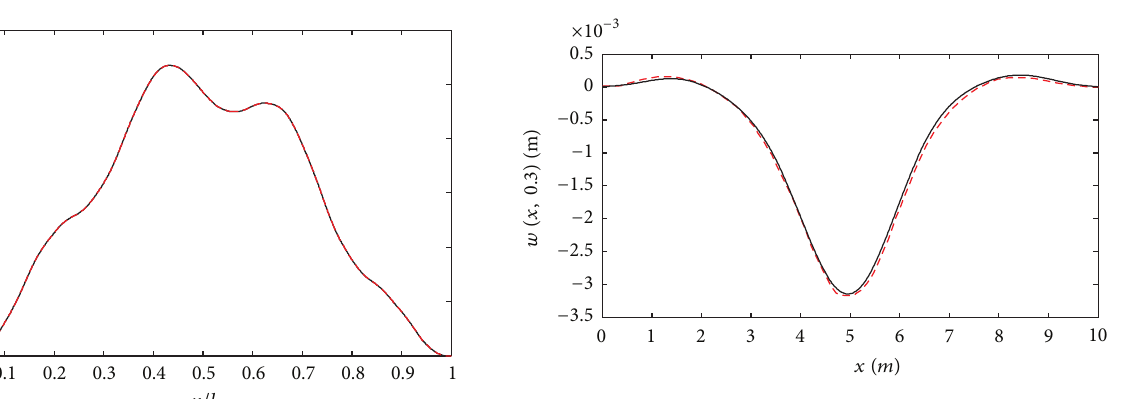
Figure 4: Lateral displacement 𝑤(𝑥,0.3) at instant 𝑡 = 0.3 s along length of the beam; (—) nonlinear analysis, present study, (- - - - -) nonlinear analysis,